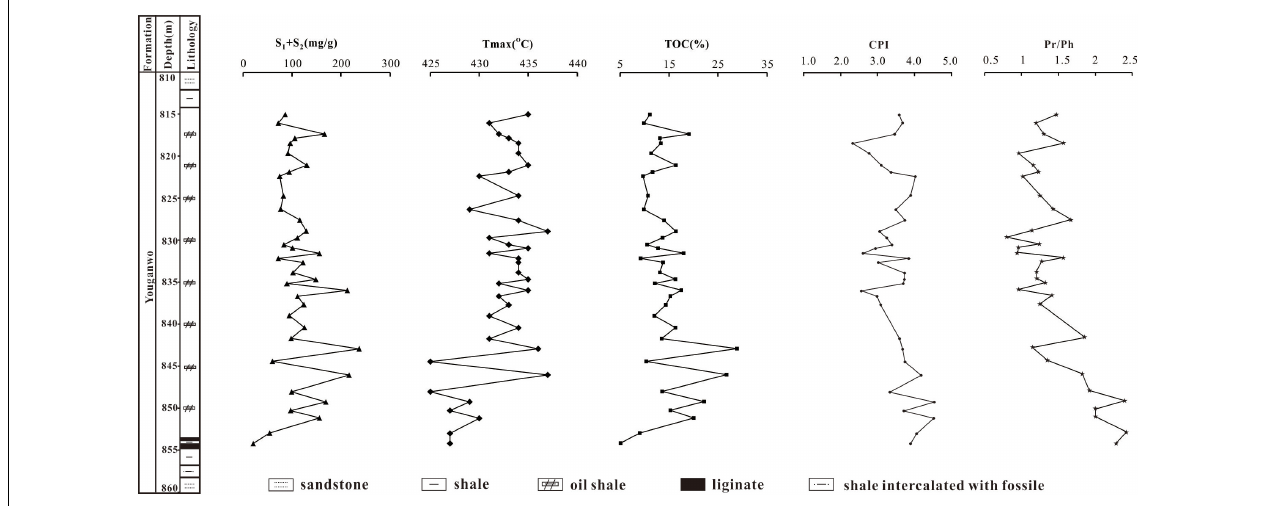
FIGURE 2 | The profile variation of TOC and pyrolytical and aliphatic parameters of Maoming oil shales (S 1 : free hydrocarbon content; S 2 : hydrocarbon content released from kerogen, CPI = 1/2[(C 25 + C 27 + C 29 + C 31 + C 33 )/(C 24 + C 26 + C 28 + C 30 + C 32 ) + (C 25 + C 27 + C 29 + C 31 + C 33 )/(C 26 + C 28 + C 30 + C 32 + C 34 )]; Pr = pristine; Ph = phytane). The stratigraphic log is a simplification of the complex sediments and should not be used to infer lithology of the samples.